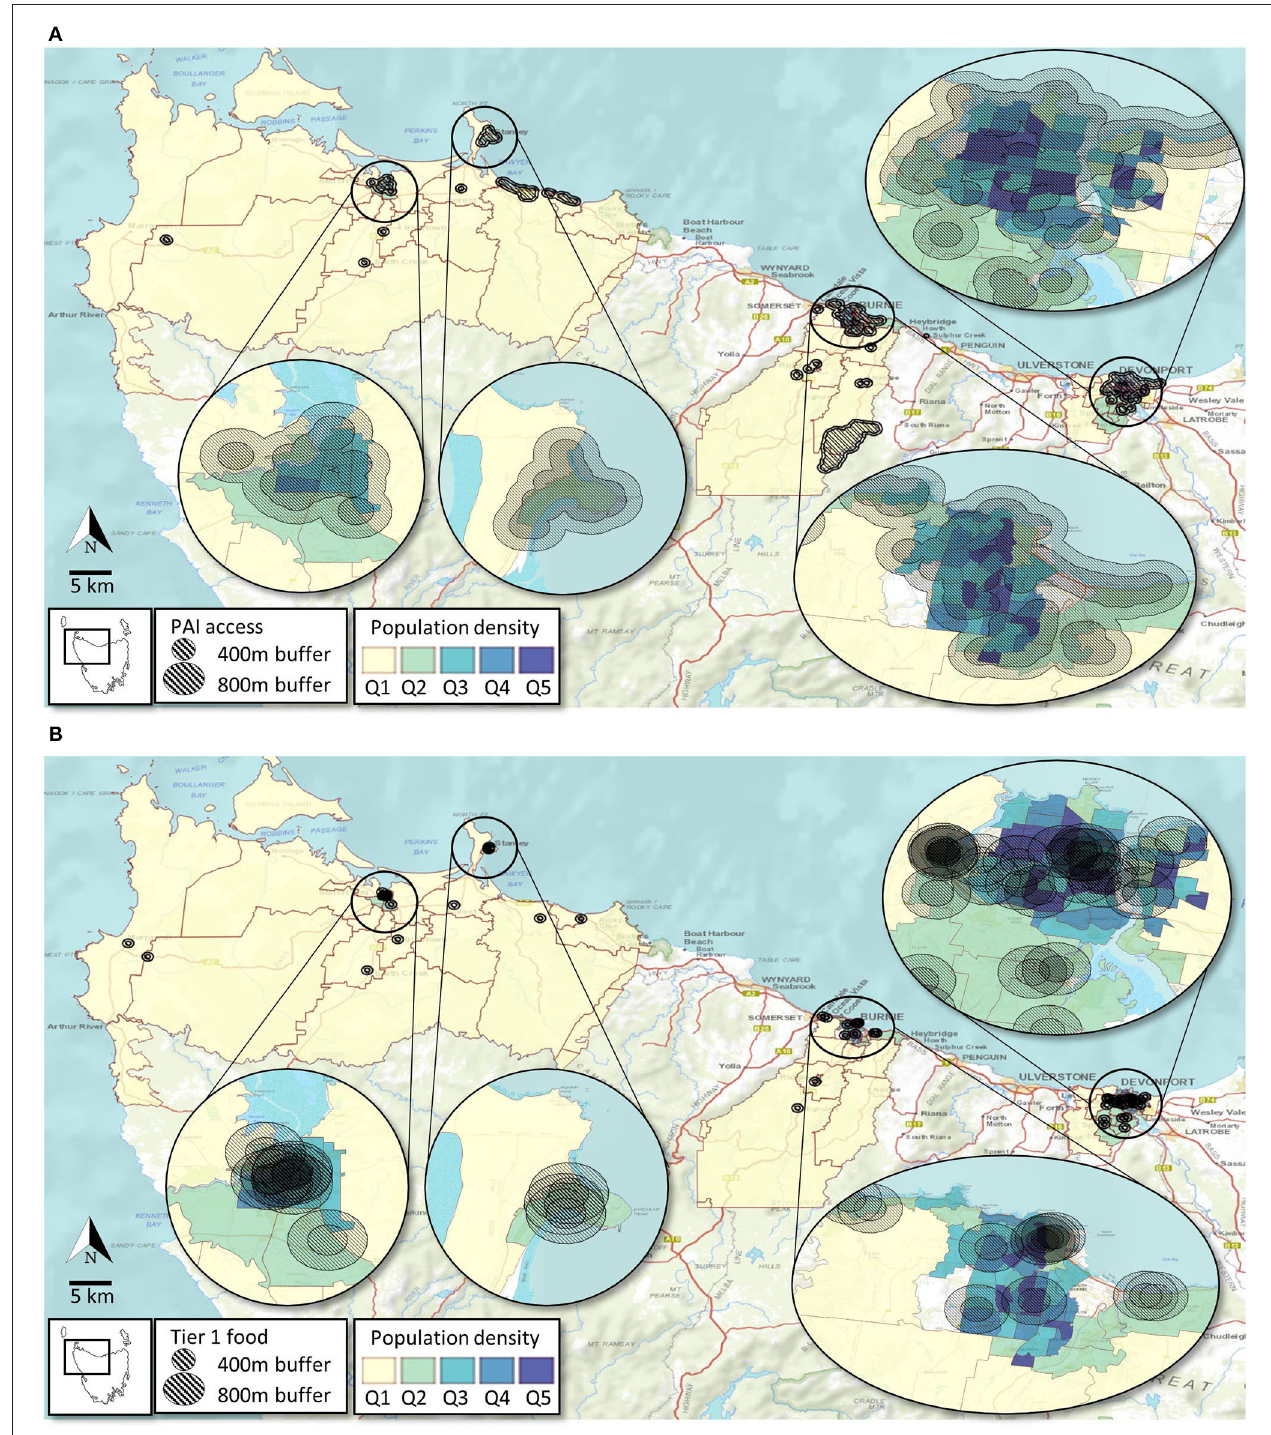
FIGURE 4 | Access to PA infrastructure (A) and Tier 1 food outlets (B) based on population density of suburbs (technically SA1s) across the study area.